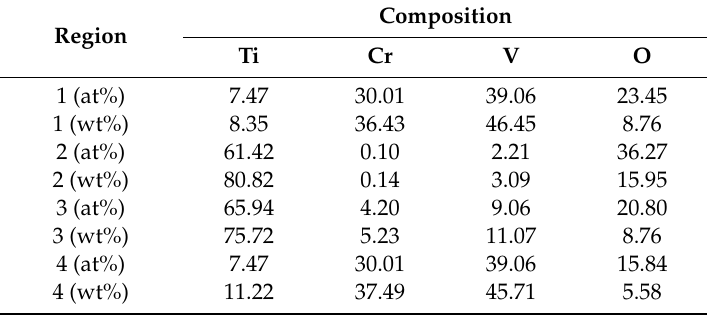
Table 1. Chemical compositions of di ff erent areas in oxide and melting zone.